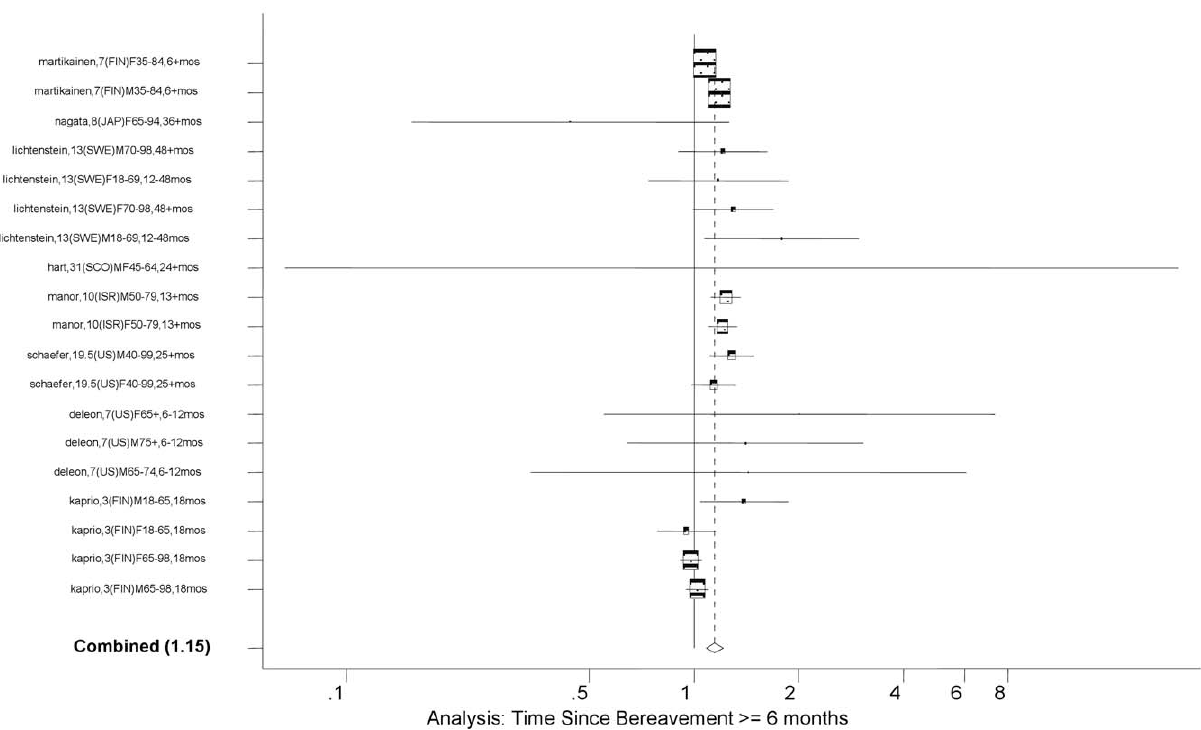
Figure 3. Forest Plot for Time Since Bereavement of $ 6 months.